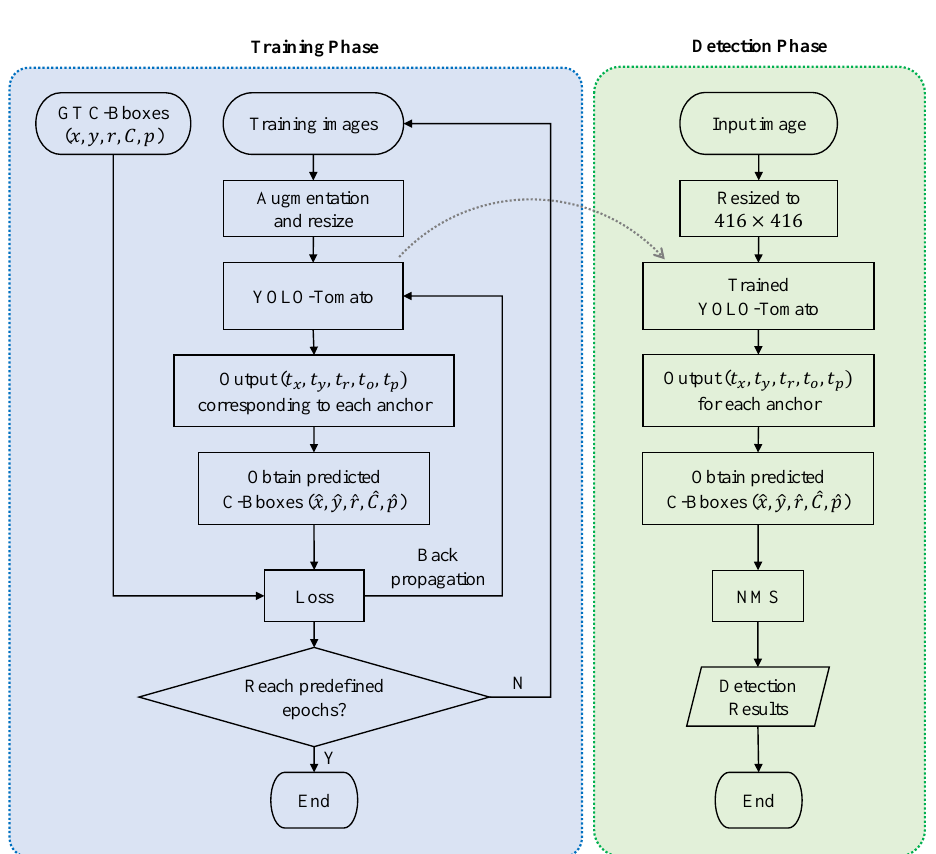
Figure 6. A flowchart of training and detection process of